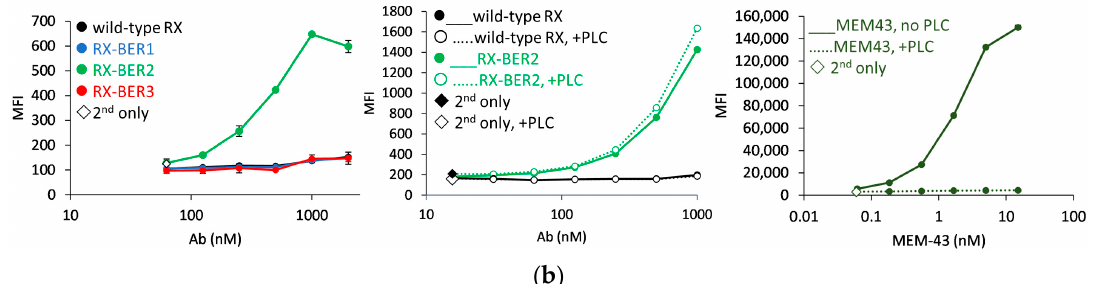
Figure 3. Cell assays with anti-CD20/anti-CD59 bispecific antibodies: ( a ) Complement-dependent cytotoxicity assay in rituximab (RX)-(left) and HuMax-20 (HX)-(right) format on Raji cells and RX- based mAb 2 on ARH-77 cells (center). Sample size was n = 3 for Raji and n = 2 for ARH-77 cells. One- way ANOVA was used to determine the significance (* 0.01 ≤ p < 0.05, ** 0.001 ≤ p < 0.01, *** 0.0001 ≤ p < 0.001, **** p ≤ 0.0001); ( b ) SK-BR-3 cell staining of RX-BER mAb 2 molecules (left panel), the interaction of RX-BER2 and RX with SK-BR-3 cells with and without phospholipase C (PLC)-treat- ment (central panel), MEM-43-staining of SK-BR-3 cells with and without PLC treatment (right panel). 2nd only: cells stained with fluorescent conjugate only, without primary antibody. Presented are mean and S.D.